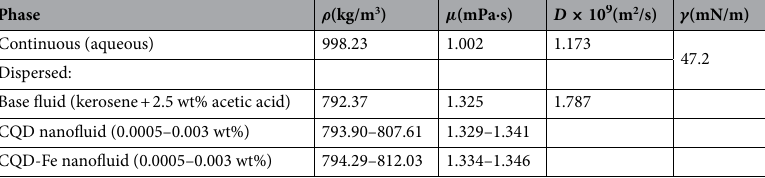
Phase ρ (kg/m 3 ) µ